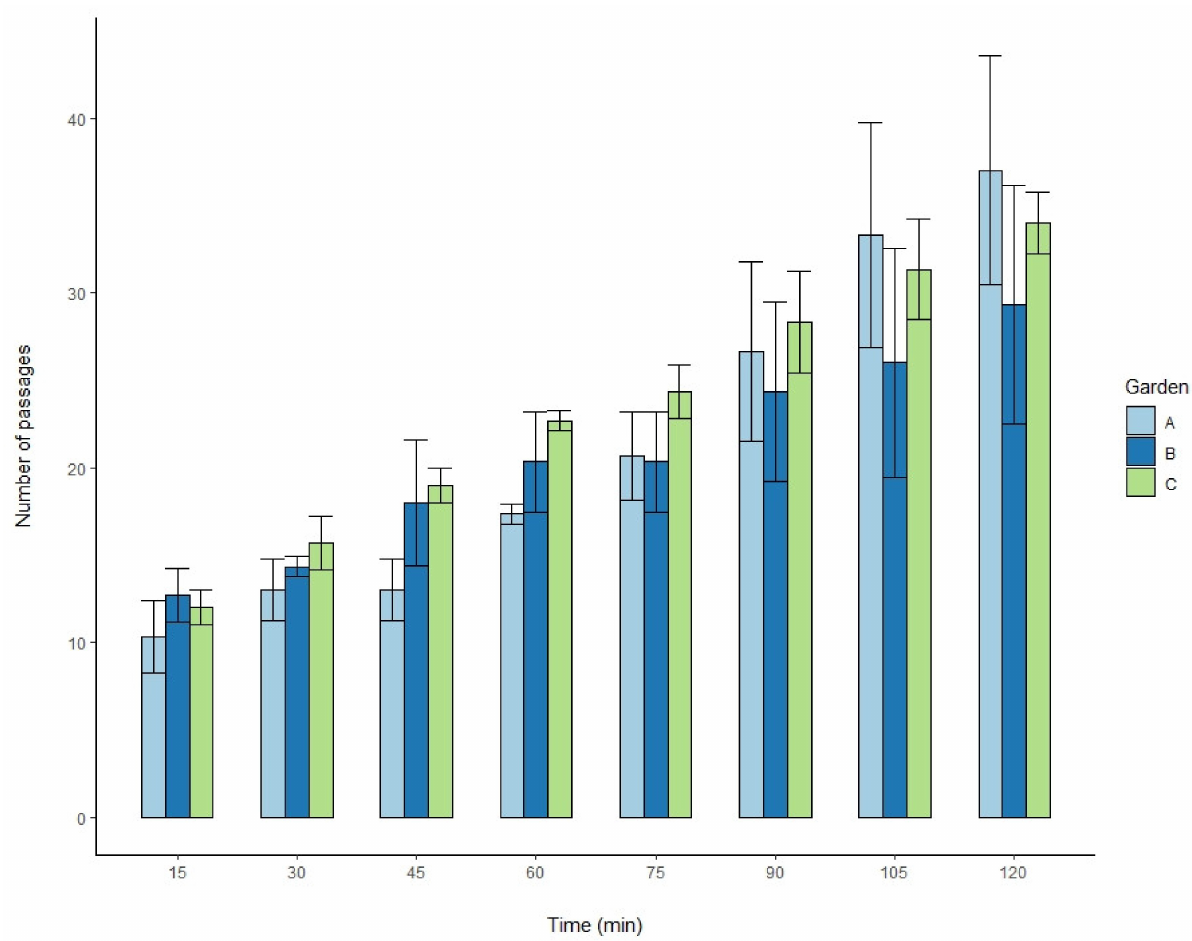
Figure 6. Back-transformed maximum number of passages in function of garden typologies and time intervals. Vertical bars represent the standard errors (A = no obstacles, B = low level of complexity, C = high level of